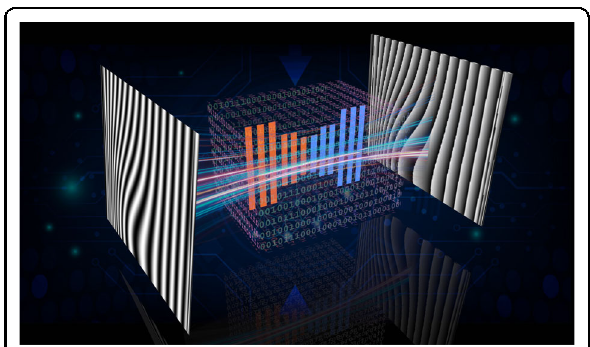
Fig. 1 The pros and cons of applying deep learning to optical metrology. In deep-learning-based fringe analysis, a well-trained neural network can transform a single fringe pattern into an accurate phase map from that almost reproduces the result of the multi-step phase-shifting method, which is an astonishing feat for the fi eld. But its internal mechanism tends to be very dif fi cult to explain ( “ Black